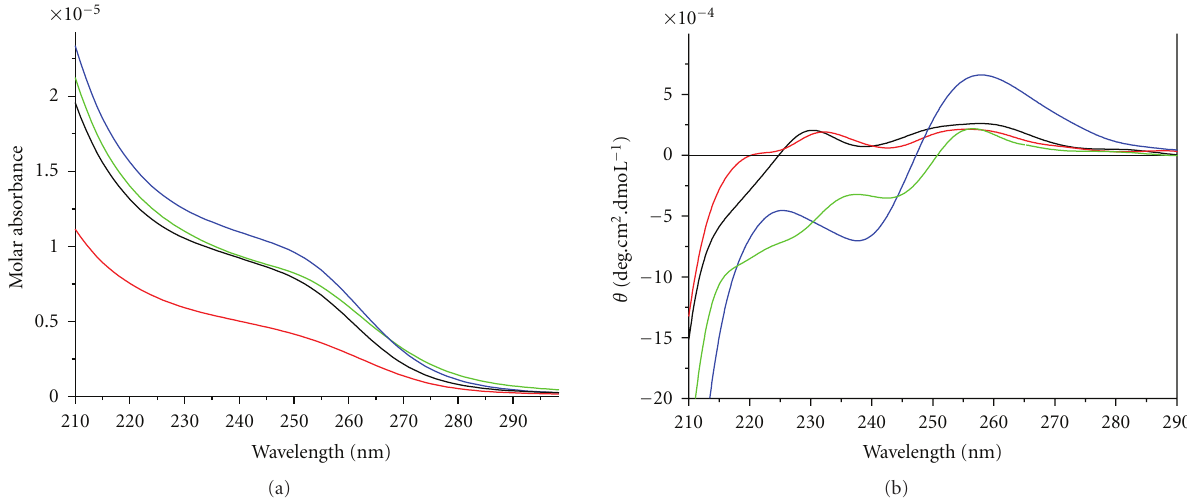
Figure 2: The UV (a) and CD (b) spectra of Cd 2+ -reconstituted hGIF ( blue line ), the Δ 33-35 mutant (green line), the β (MT3)- β (MT3) mutant (black line), and the single β -domain of hGIF (red line). All proteins are dissolved in 10 mM Tris-HCl, 100 mM KCl (pH 8.0).